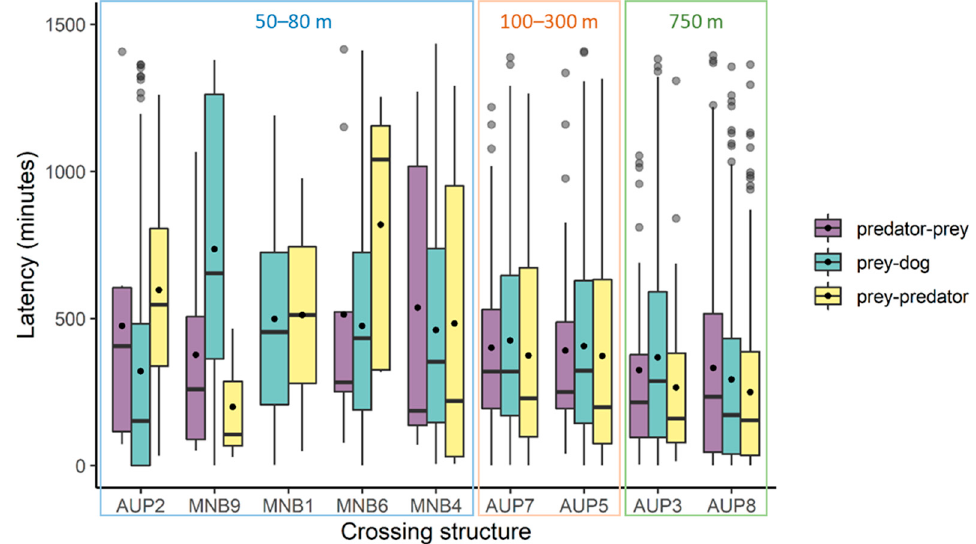
Figure 4. Variation in mean latencies (black dots) of predator–prey, prey–dog and prey–predator latencies at animal crossing zones on National Highway 44. Structures have been arranged in increasing order of width (AUP = animal underpass; MNB = minor bridge). Grey dots represent outliers.